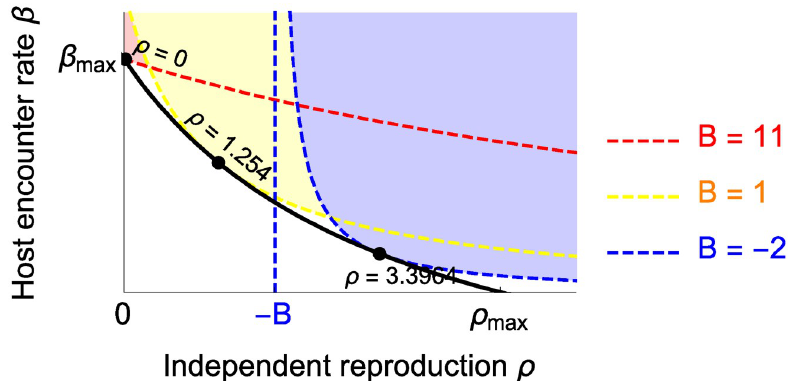
Fig 4. Effect of the compound benefit ( B = b − ν + σ ) on the ESSs in the case of a concave trade-off curve (black line) under the assumption that the bound reproduction is τ ( x ) = ρ ( x ) + b , where b is the bonus reproduction by exploiting the host. Trade-off and host population are as in Fig 3. Dashed lines are the invasion boundaries that separate shaded areas in which mutants can invade and blank areas in which mutants cannot. Black points indicate the ESS values that are corresponded with different values of B . Other parameters: c = 2, N = 100, μ 0 = 3, ω = 6.5, β max = 5, α = 3.1, δ = 1.3, σ = 0.